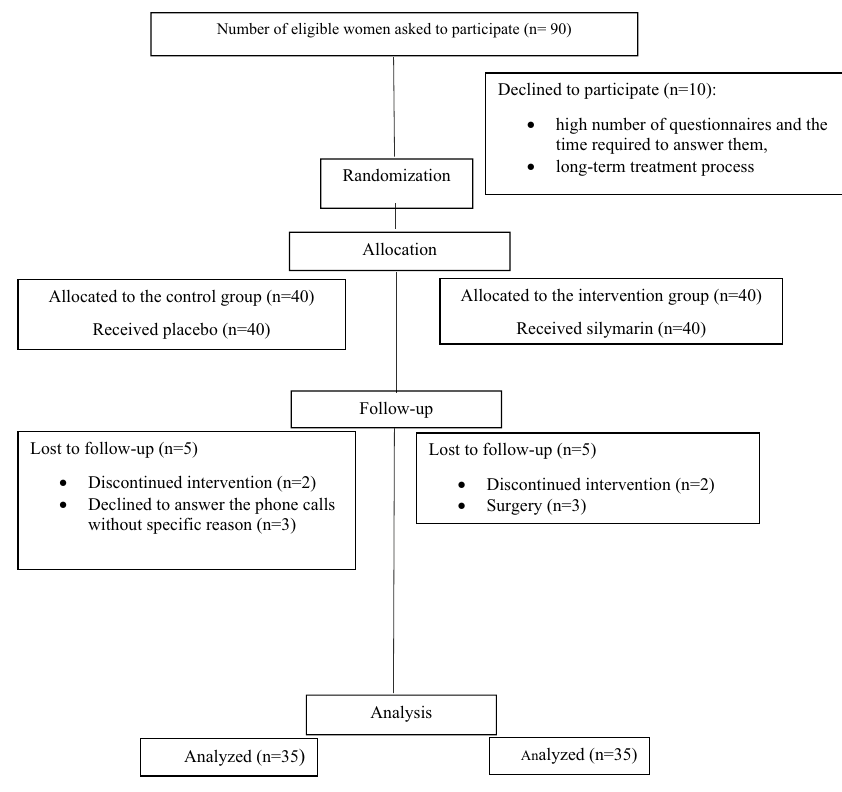
Figure 1. Flowchart of participants: women screened for eligibility, admitted to and randomized in the study on the use of the silymarin